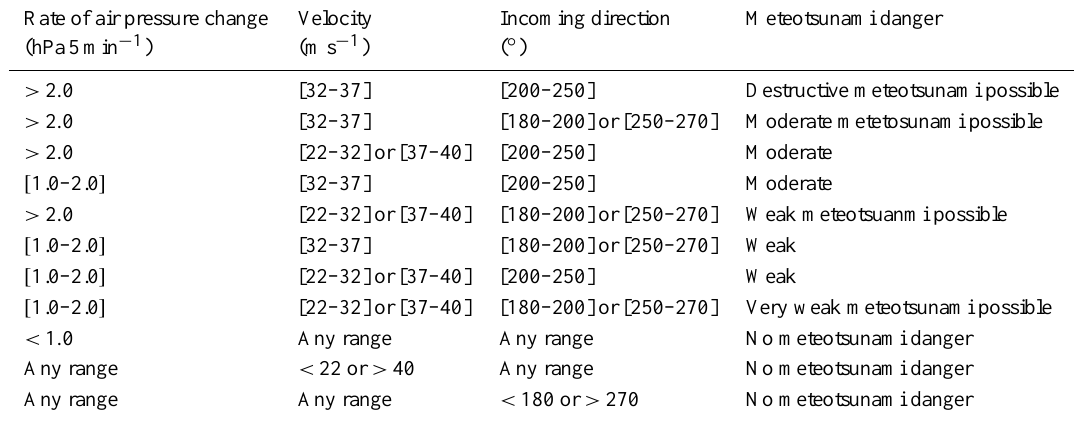
Table 2. Preliminary meteotsunami warning matrix for Vela